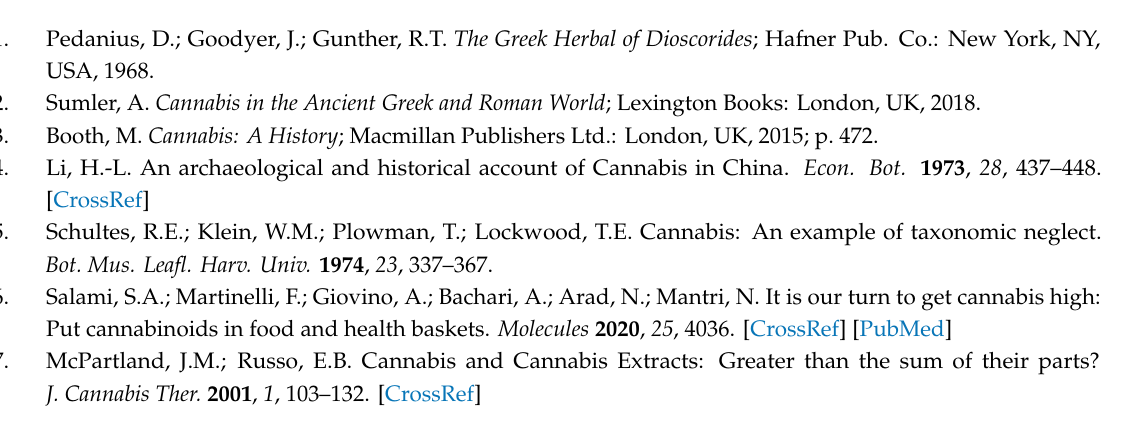
Supplementary Materials: The following are available online, Figure S1. The e ff ect of medium strength and plant growth regulators’ concentration on the average number of shoots per explant of the high CBD and CBG Cannabis sativa varieties. Figure S2. The e ff ect of medium strength and plant growth regulators’ concentration on the average length (cm) of shoots per explant of the high CBD and CBG Cannabis sativa varieties. Figure S3. The e ff ect of medium strength and plant growth regulators’ concentration on the shoot formation percentage (%) of the high CBD and CBG Cannabis sativa varieties. Figure S4. The e ff ect of medium strength and plant growth regulators’ concentration on the average number of roots per shoot of the high CBD and CBG Cannabis sativa varieties. Figure S5. The e ff ect of medium strength and plant growth regulators’ concentration on the average length (cm) of roots per shoot of the high CBD and CBG Cannabis sativa varieties. Figure S6. The e ff ect of medium strength and plant growth regulators’ concentration on the rooting. Figure S7. The CBD + CBDA and CBG + CBGA content (%) of the field grown mother plants and their clones of the two high CBD and CBG Cannabis sativa varieties. Table S1. CBD + CBDA and CBG + CBGA content (%) of the field grown mother plants and their clones at di ff erent developmental stages of the two high CBD and CBG Cannabis sativa varieties (Data represent average ± standard